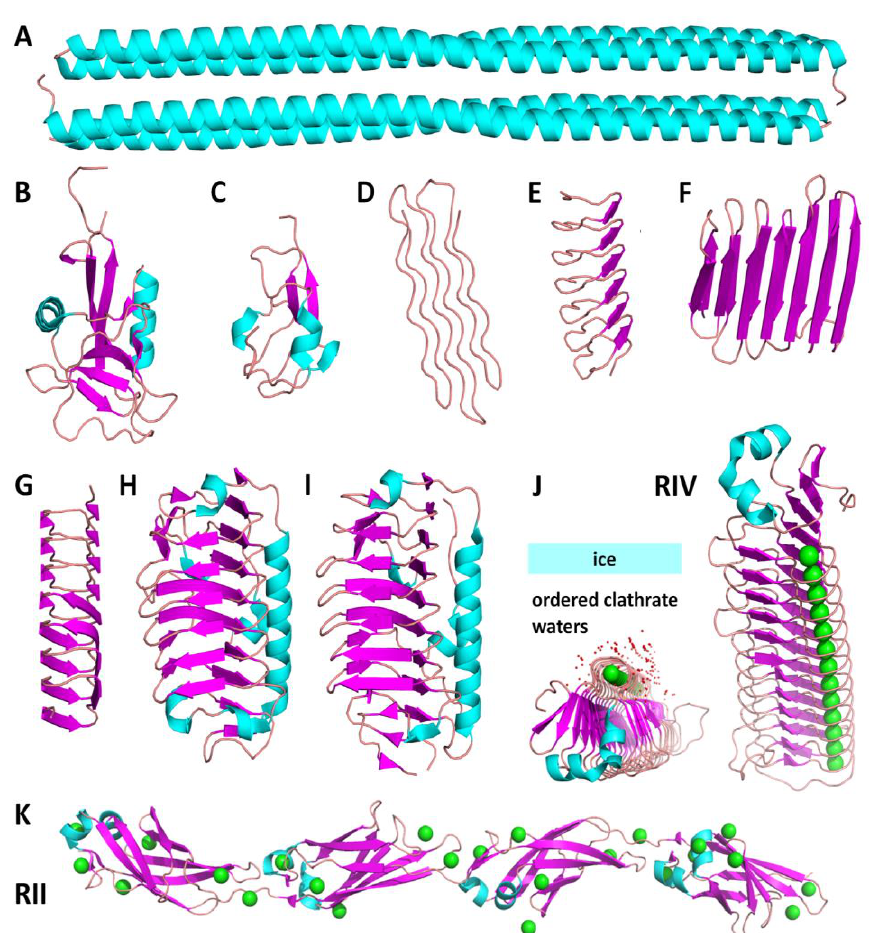
Figure 2. Structures of the antifreeze proteins (AFPs) of different origins. Models of the experimental structures were accessed from the Protein Data Bank (PDB) and presented as a cartoon view. Cyan indicates an α-helix, magenta—a β-strand, pink—a loop, red—waters, green—Ca 2+ ions. ( A – C ) fish